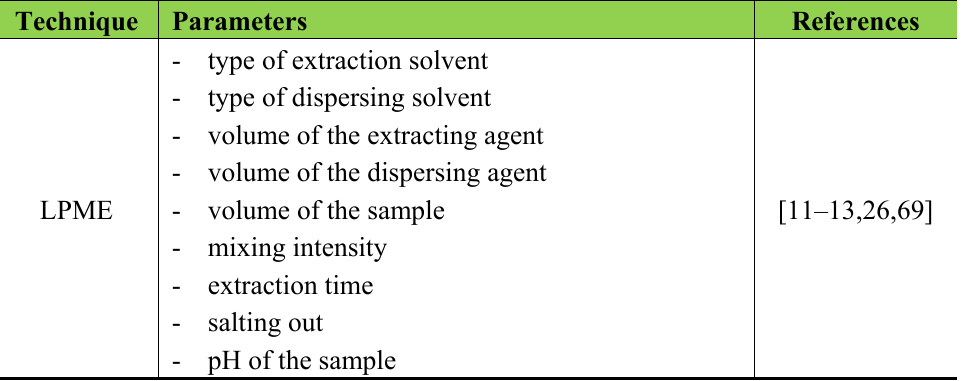
Table 4. Parameters affecting the efficiency of the microextraction processes.